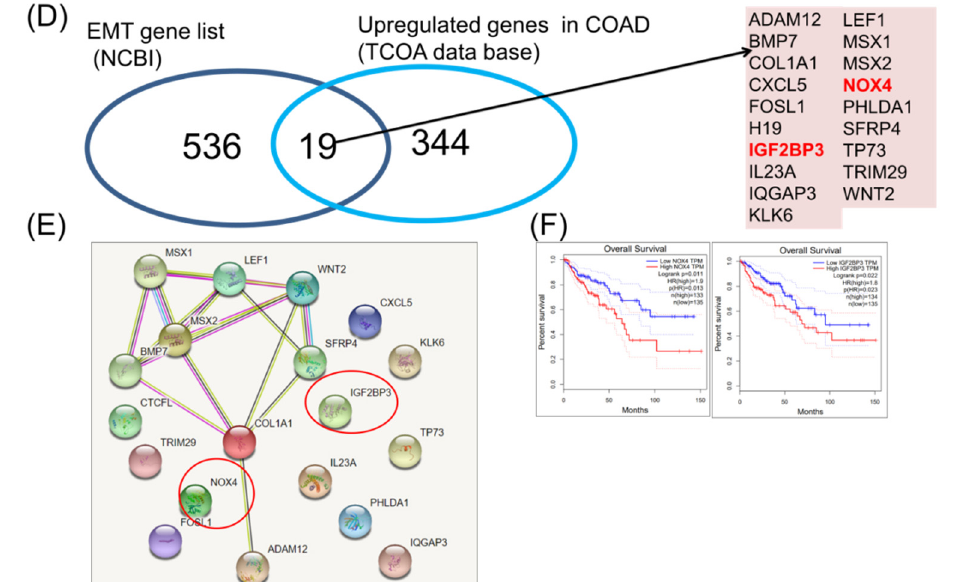
Figure 2. Common EMT downregulated and upregulated gene expression signature in COAD. ( A ) Venn diagram used to shows the common signature among the EMT gene list (downloaded from NCBI) and the downregulated genes in COAD, red letters—genes predict overall survival; ( B ) interaction network using String software for 34 downregulated genes common with EMT mechanisms, red circles—genes that predict overall survival outcomes; ( C ) COAD downregulated genes involved in EMT (DACT3, EEF1A2, BMP5, GCNT2 and SFRP1) predicting overall survival; ( D ) Venn diagram used to show the common signature among the EMT gene list (downloaded from NCBI) and the upregulated genes in COAD, red letters—genes predict overall survival; ( E ) interaction network using String software for 19 overexpressed genes common with EMT mechanisms, red circles—genes predict overall survival outcomes; ( F ) COAD overexpressed genes involved in EMT (NOX4 and IGF2BP3) predicting overall survival.